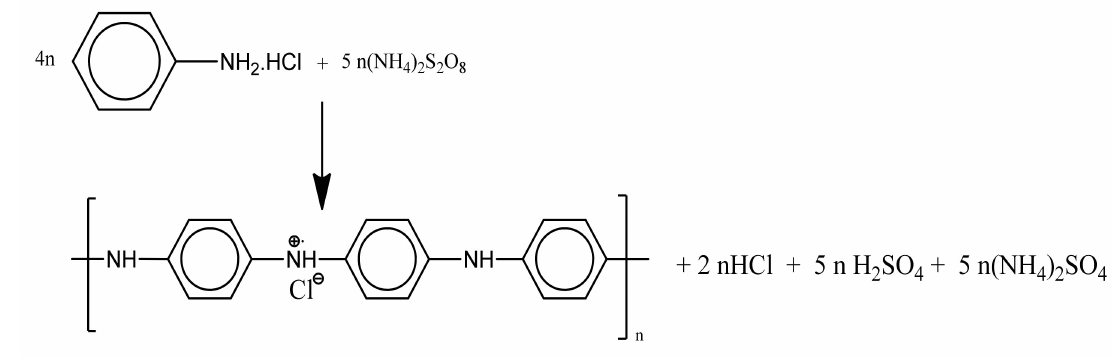
Scheme 1. Synthesis of polyaniline.